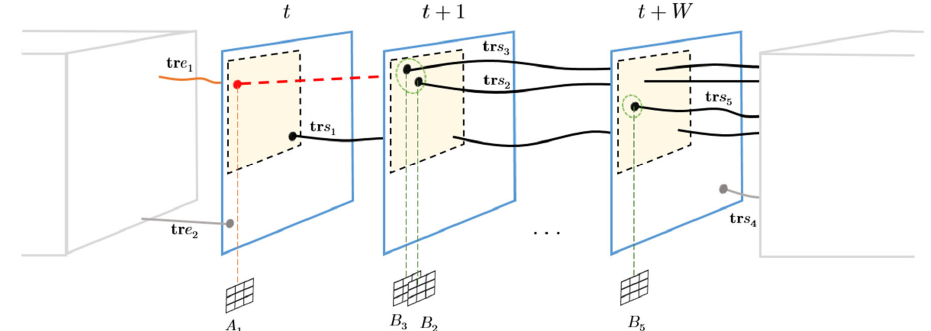
Figure 4. A spatio ‐ temporal schematic example shows the final corrected tracklet 𝐭𝐫 (cid:2869) that resulted from connecting 𝐭𝐫𝑒 (cid:2869) and 𝐭𝐫𝑠 (cid:2871) tracklets after applying HTA algorithm.